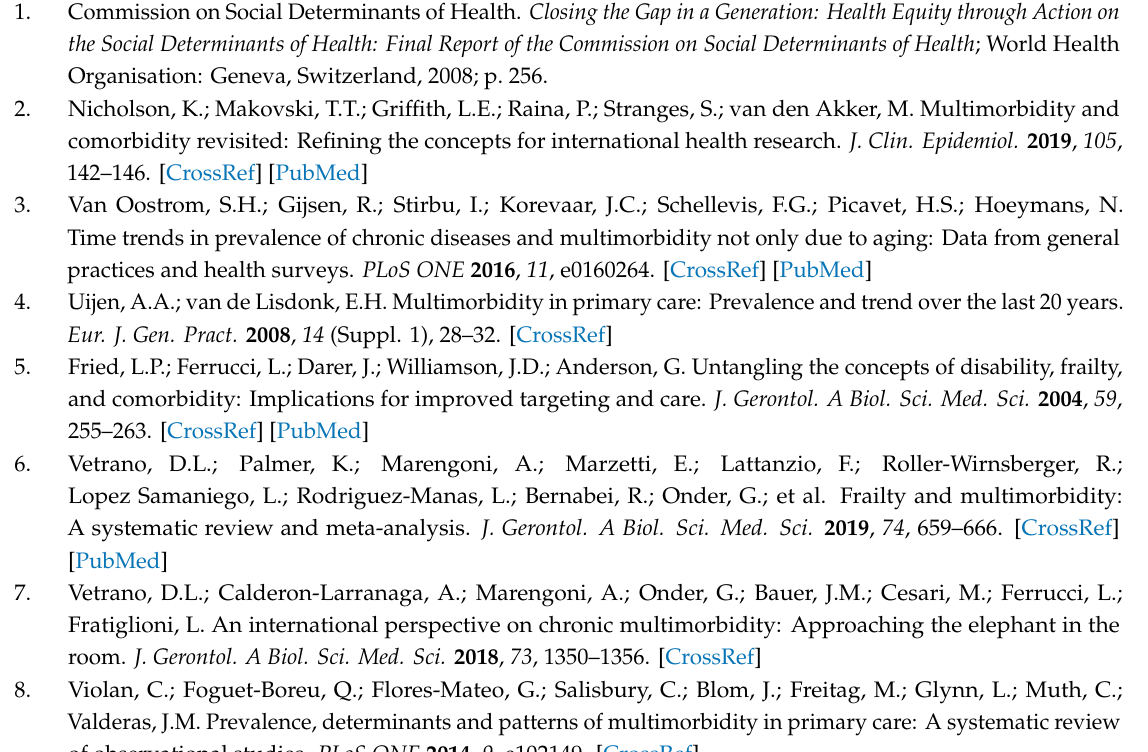
Classification scheme. Supplementary data 3: Estimated 10-year risk of death by all individual and organ-grouped chronic conditions, occupational groups and sex and descriptive data; Figure S1. Estimated 10-year all-cause risk of death by number of individual chronic conditions and cccupational group, women & men; Table S3. 10-year Table S4. 10-year mortality by increasing organ-grouped chronic conditions, by sex and occupational strata. Supplementary data 4: Descriptive data supplementary to hazard ratios for mortality of combined occupational group and health status; Table S5. Number of deaths by occupational group and health status in women and men. Supplementary data 5: Baseline sociodemographic characteristics of eligible, non-eligible and